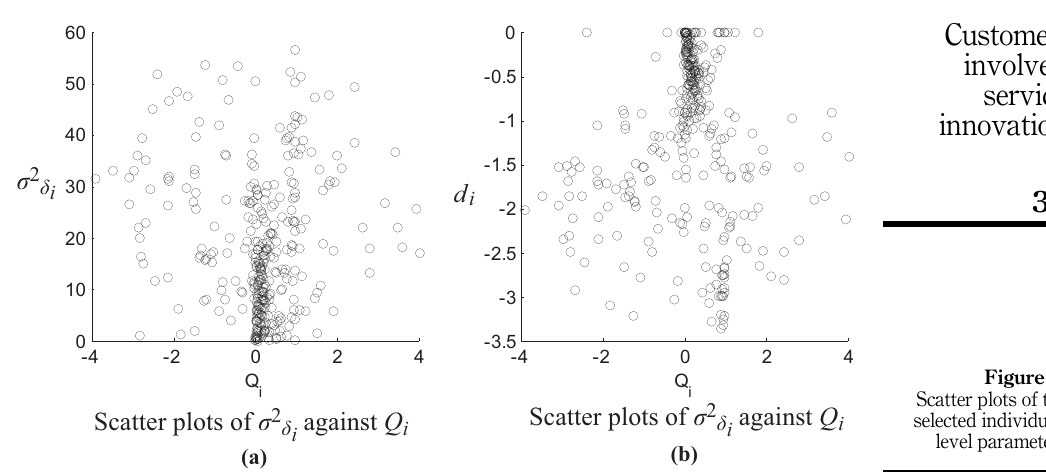
Figure 3. Scatter plots of the selected individual- level parameters